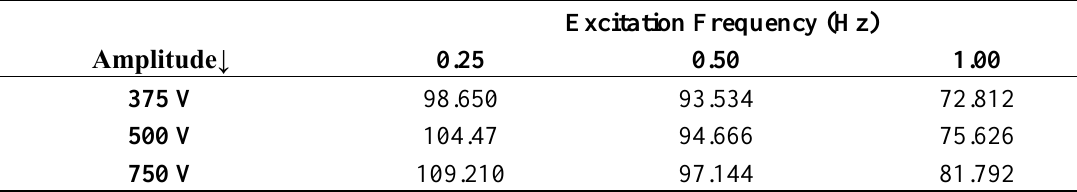
Table 10. Variation of the mass matrix coefficient 